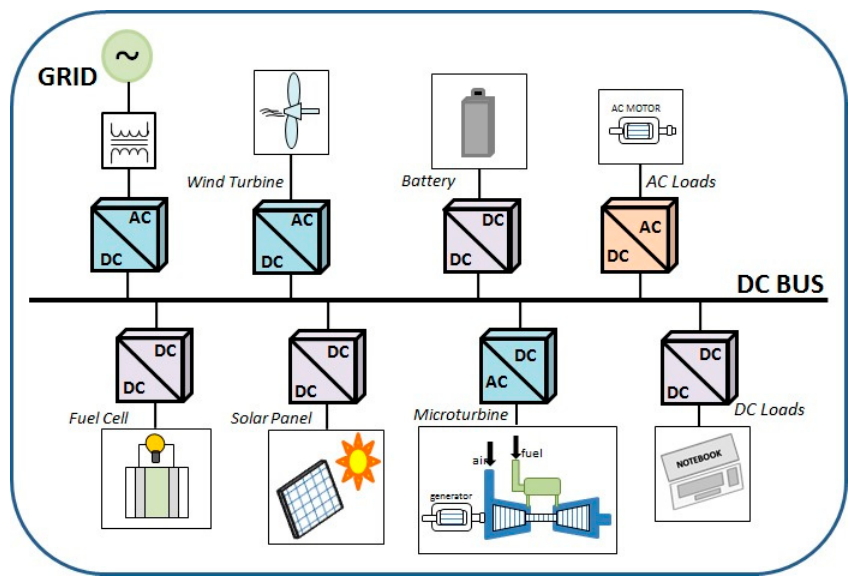
Figure 1. Typical configuration of a DC microgrid.